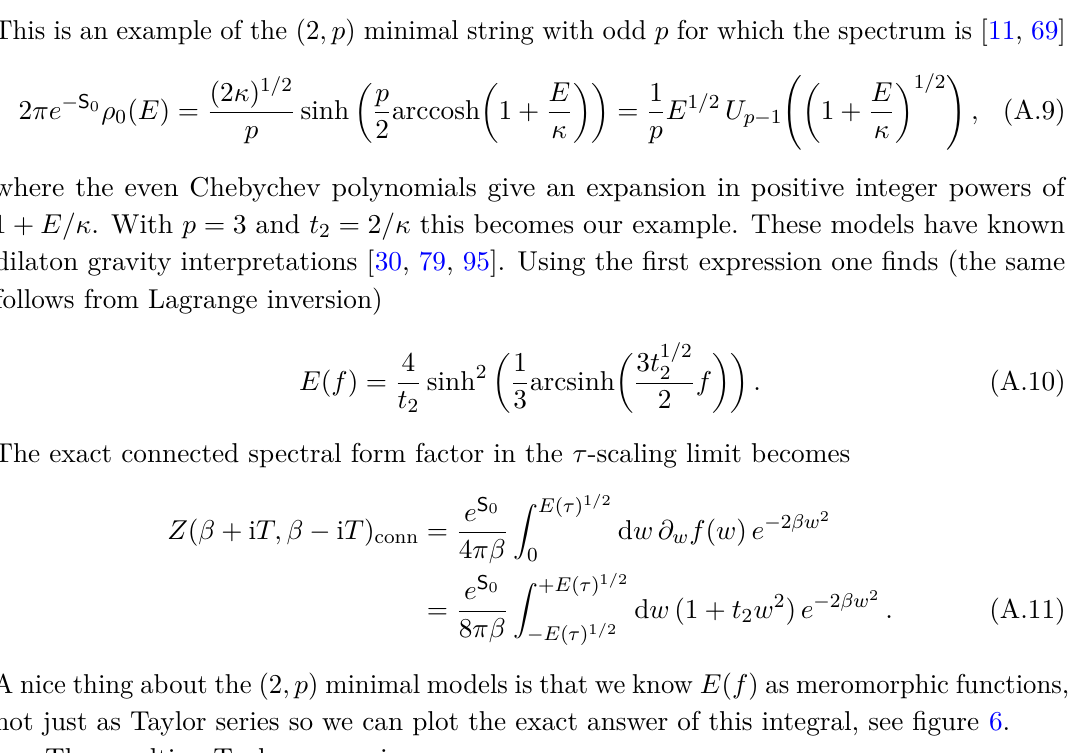
Figure 5 . The τ -scaling limit of the sum over genus g wormholes in JT gravity (A.5) with e S 0 = 10 and β = 1 / 2 . We have not shown individual terms in the series, because it converges only when Te − S 0 < 1 / 2 π , which is a very short time on this plot. Importantly though, the sum over all genus uniquely gives the exact answer (A.5). The JT plateau is much higher and hence reached much later than the Airy plateau, because of the exponentially larger spectral